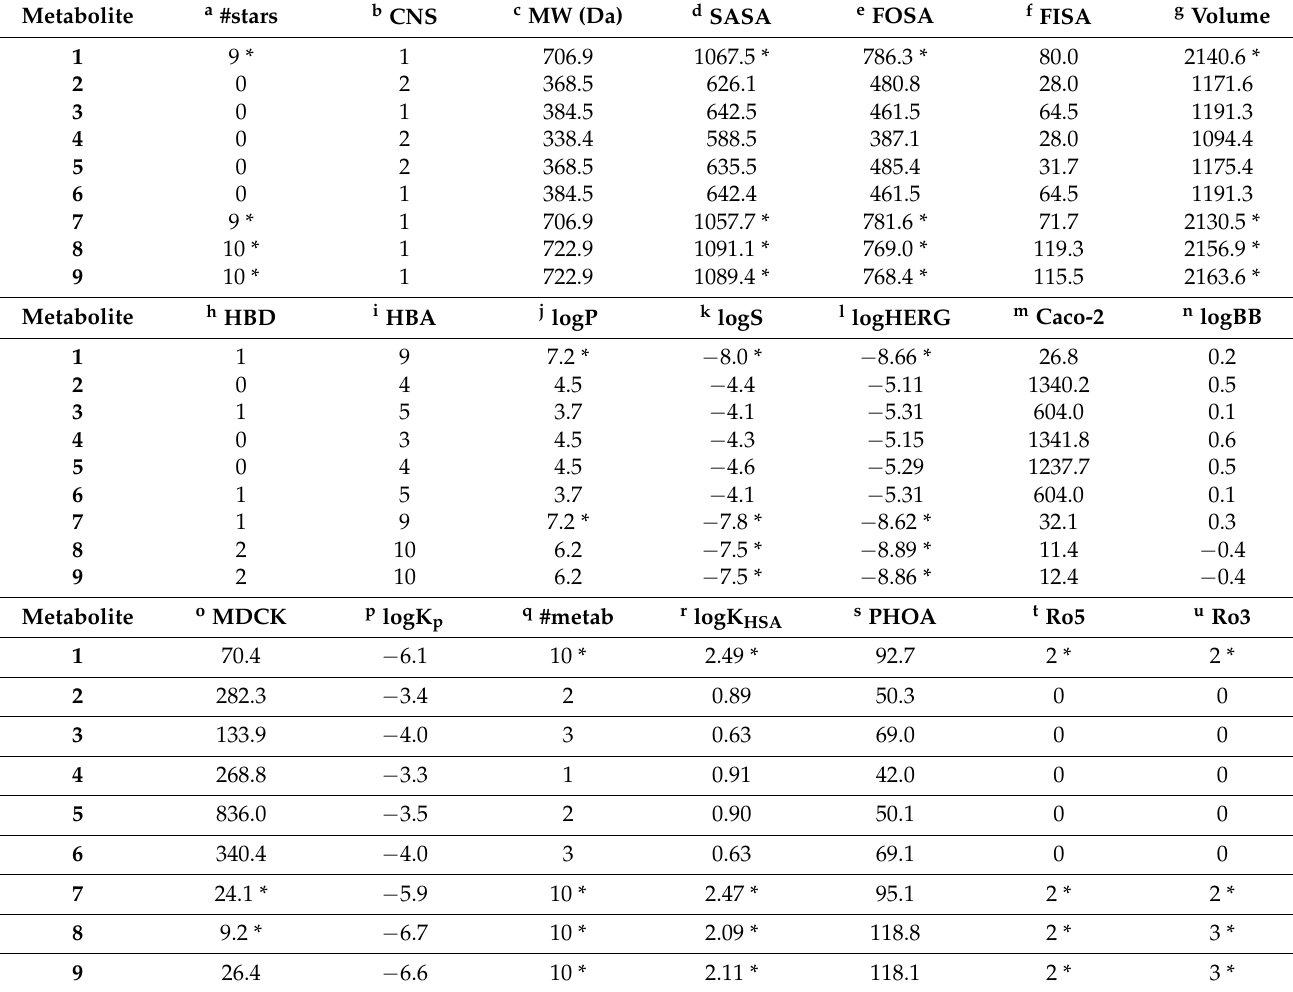
Table 4. Computed molecular descriptors for the assessment of the drug metabolism and pharmacokinetics (DMPK) profiles of the major isolated metabolites and the recommended range for 95% of known drugs.